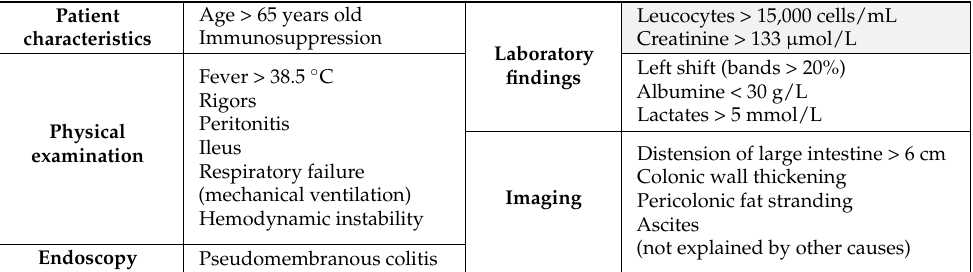
Table 1. Severity criteria according to ESCMID and IDSA/SHEA [16,38]: IDSA/SHEA criteria are shown on the grey